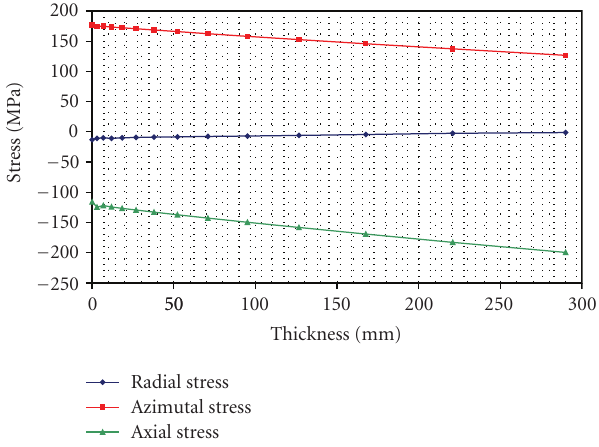
Figure 14: Mechanical stress through thickness.